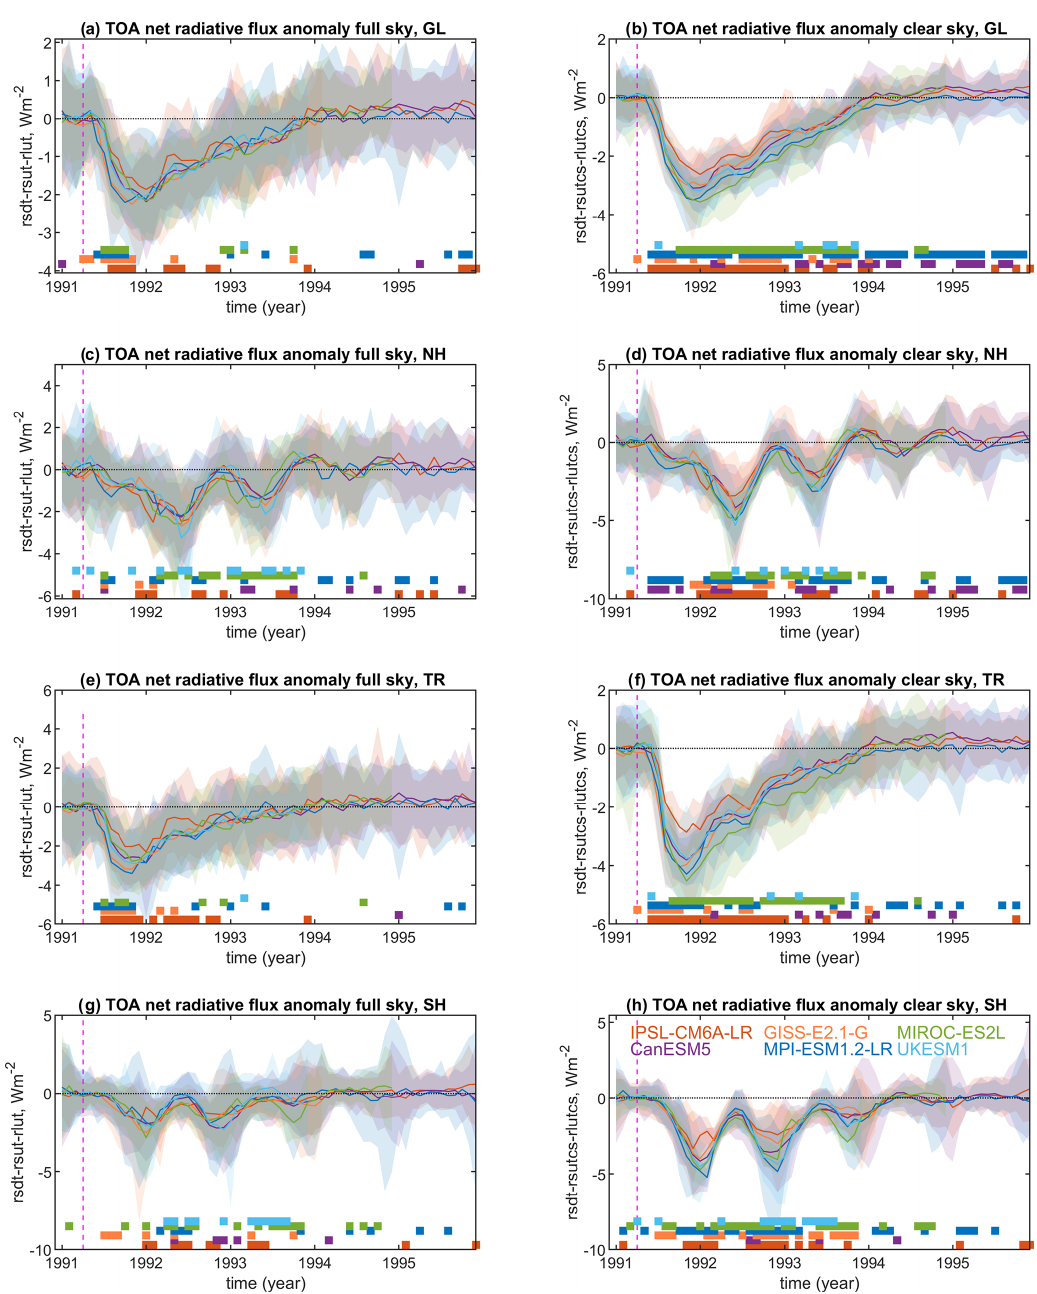
Figure 4. Top-of-atmosphere (TOA) net vertical radiative flux anomalies under full-sky (a, c, e, g) and clear-sky (b, d, f, h) conditions in the volc-pinatubo-full multi-model ensemble for (a, b) global (GL), (c, d) Northern Hemisphere extratropical (NH), (e, f) tropical (TR) and (g, h) Southern Hemisphere extratropical (SH) mean. Full-sky anomalies are calculated as incoming shortwave (rsdt) minus outgoing short- wave (rsut) minus outgoing longwave radiation (rlut); clear-sky anomalies are calculated as rsdt minus clear-sky outgoing shortwave (rsutcs) minus clear-sky outgoing longwave radiation (rlutcs). For each model, the shading illustrates the ensemble envelope, and the line the en- semble mean. Positive anomalies indicate increased downward flux. Squares at the bottom indicate when one model output is significantly different ( p < 0 . 05) from the ensemble members of all the other models according to the Mann–Whitney U test. The vertical dashed magenta line indicates the approximate timing of the